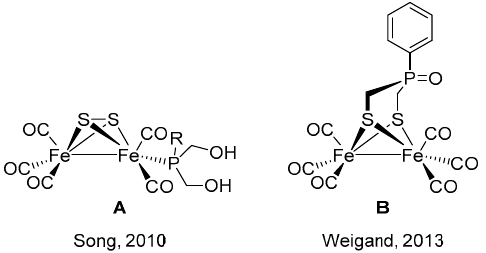
Figure 3. Phosphorous containing models of the diiron subsite of [FeFe]-hydrogenases [13,14].